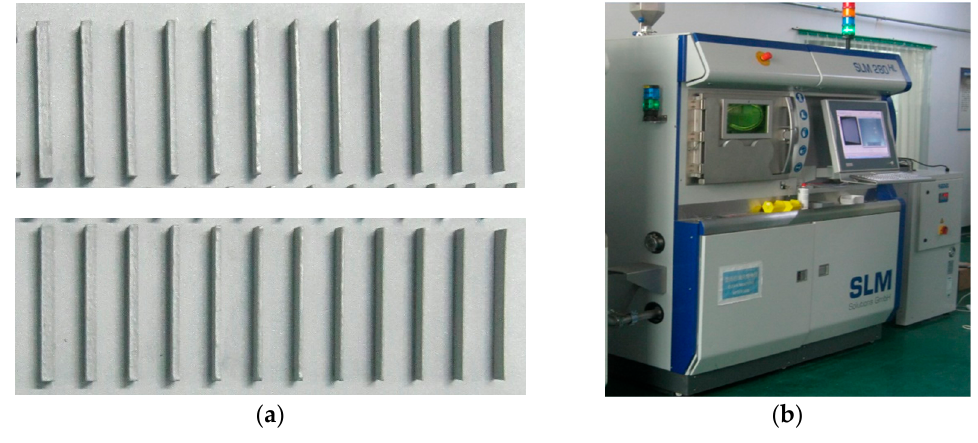
Figure 4. ( a ) Developed Samples ( b ) SLM 280HL System.